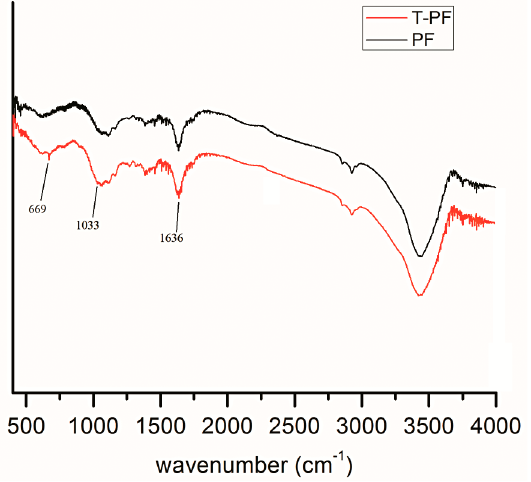
Figure 2. Fourier transform infrared spectra of PF and T-PF.